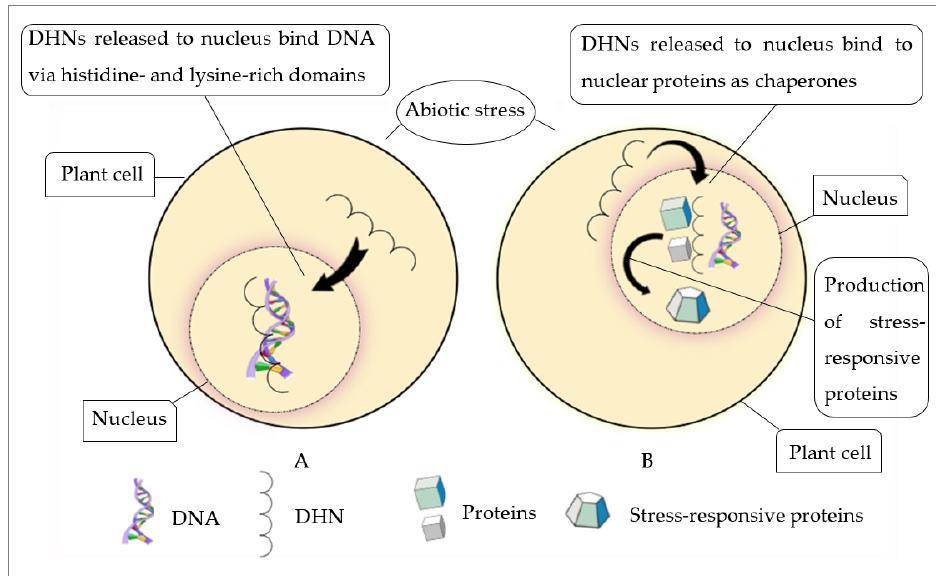
Figure 3. Role of DHNs inside the nucleus of a cell ( A —binds to DNA, B —binds to other protein molecules). ( A ) Nuclear-localized DHN under stress conditions binds to DNA because of the presence of DNA-binding domains (histidine and lysine), which may repair or protect the DNA from damage caused by abiotic stresses. ( B ) DHNs shield protein molecules through protein–protein interaction as chaperones in the nucleus and facilitate the production of stress-responsive proteins.